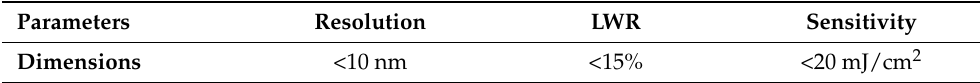
Table 2. Parameters required for resist at the industrial level